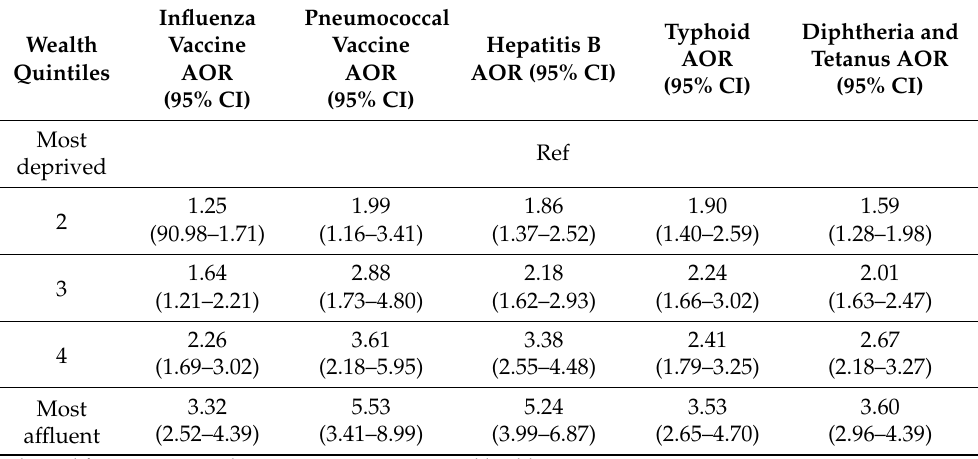
Table 3. Association between uptake of various adult vaccines and wealth quintiles among older adults in India.